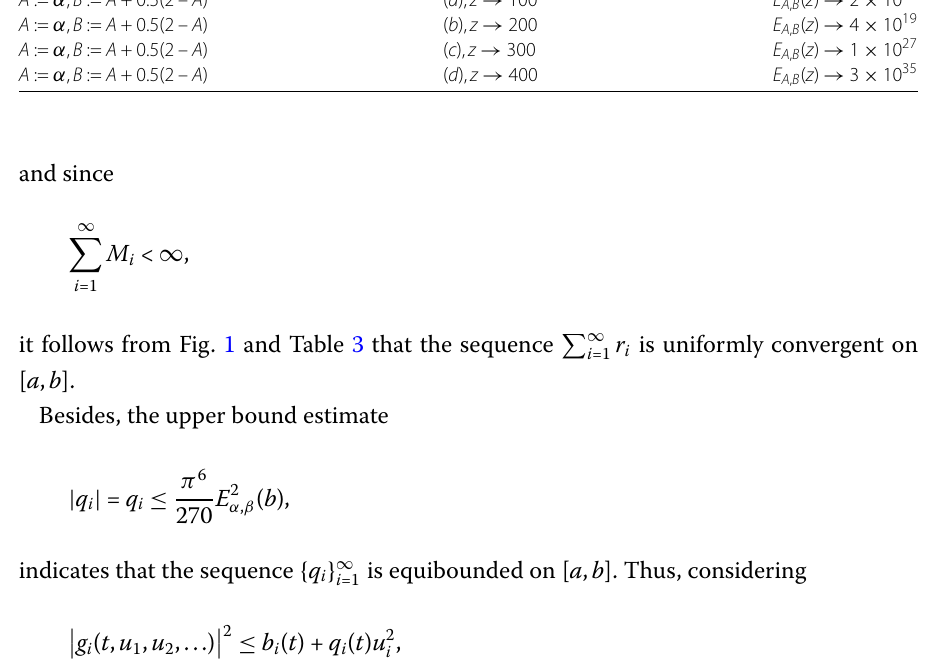
Table 3 Numerical data corresponding to Fig. 1 A , B Growth of z Growth of E A , B ( z ) A := α , B := A + 0.5(2 – A